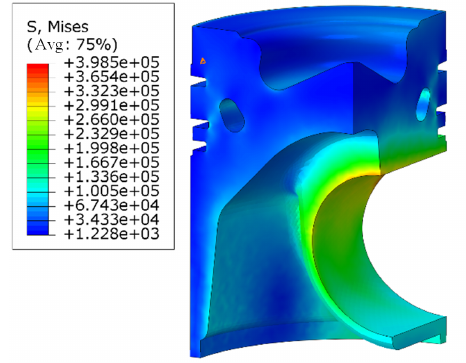
Fig. 11. Thermo-mechanical coupling stress distribution for 60 µ m AlCrN coated pistons